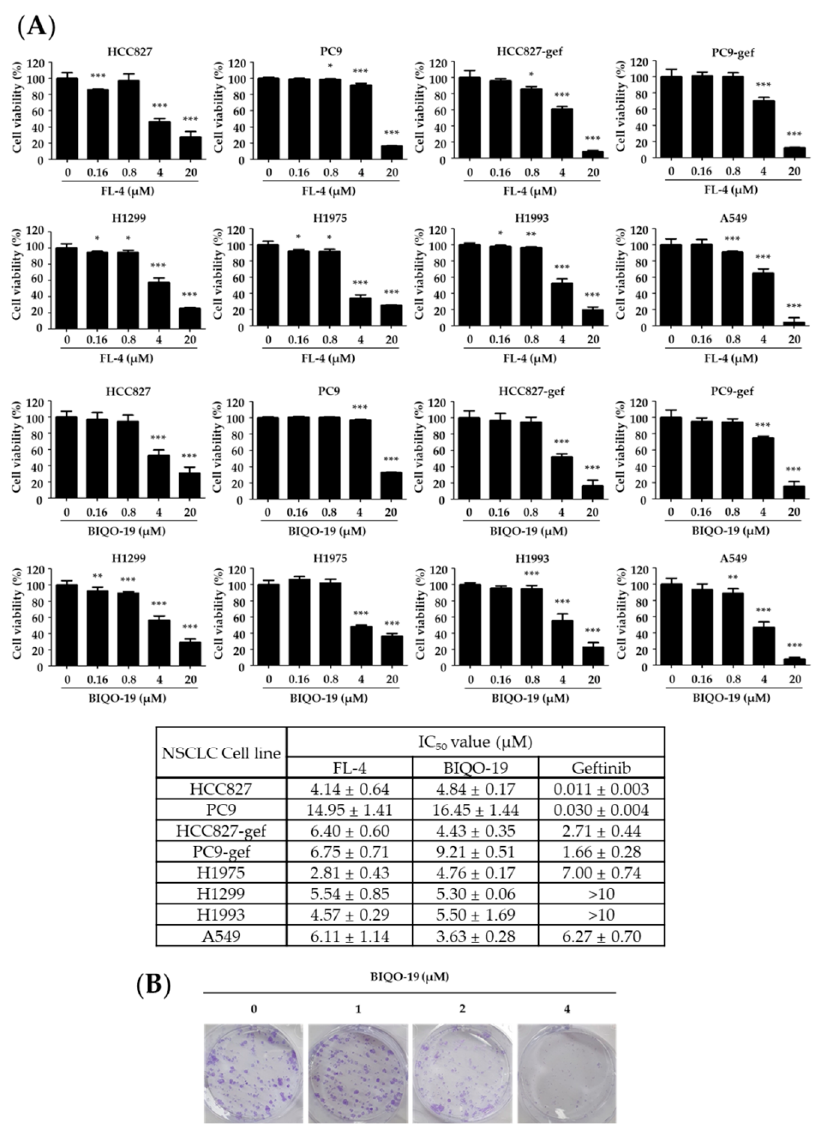
Figure 2. Effects of quinazolin-4(3 H )-one derivatives on the proliferation of NSCLC cells. ( A ) Diverse NSCLC cell lines were treated with quinazolin-4(3 H )-one derivatives for 72 h and cell proliferation was measured using a sulforhodamine B (SRB) assay. All data are expressed as the means ± standard deviation (SD) from three independent experiments. * p < 0.05, ** p < 0.01, and *** p < 0.001 indicate statistically significant difference compared with the vehicle-treated control group. The results are summarized in the table as half-maximal concentration (IC 50 ) values for the compounds ( µ M) calculated from the mean of triplicate measurements. ( B ) Effect of BIQO-19 on colony formation in EGFR-TKI-resistant H1975 cells. The cells were treated with various concentrations of BIQO-19 for 48 h, washed, and incubated for an additional ten days. The colonies were fixed and stained with crystal